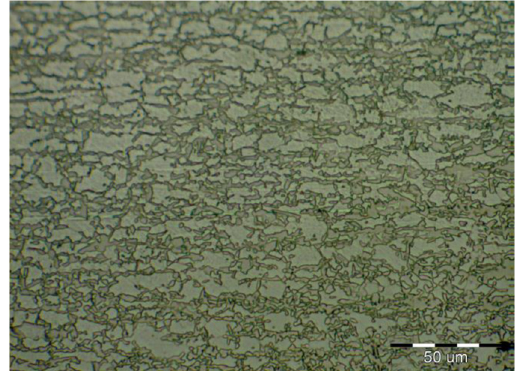
Figure 17. Detail of the TRIP base material microstructure.